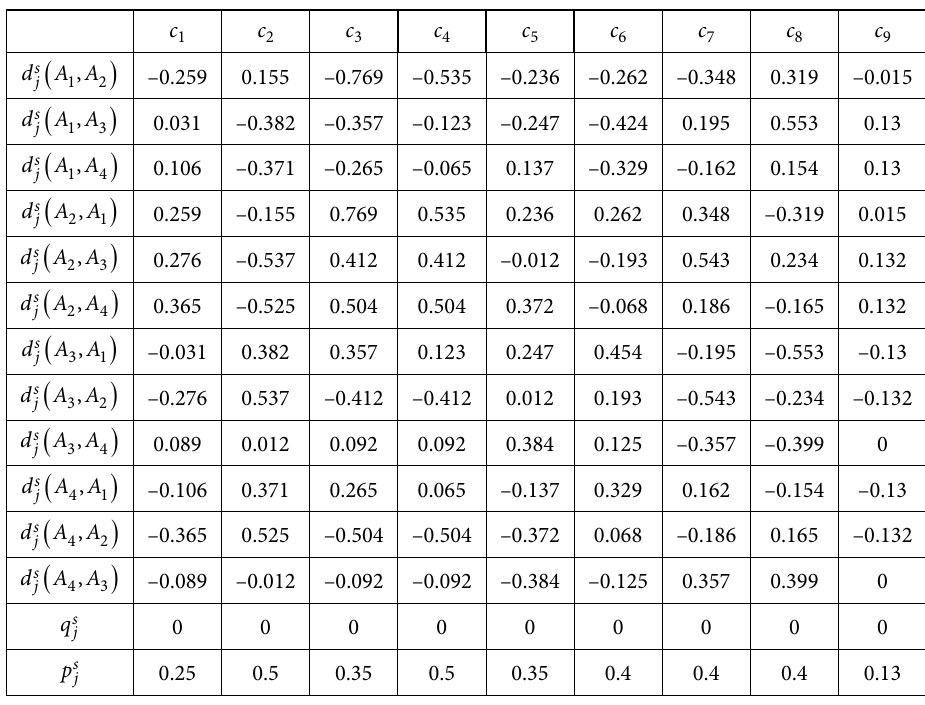
Table 2. Subjective deviations among alternatives over each attribute